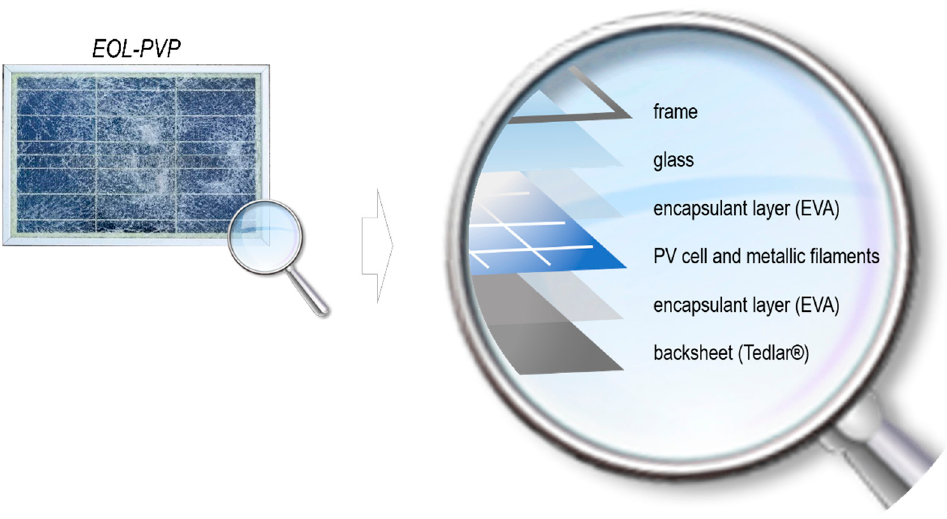
Figure 1. Exploded diagram representing the main components of a EOL-PVP: Al frame (10%), glass (69–75%), polymers (7–15%), PV cell (3%), and metallic filaments (1%) [5,17,18]. glass (69–75%), polymers (7–15%), PV cell (3%), and metallic filaments (1%)